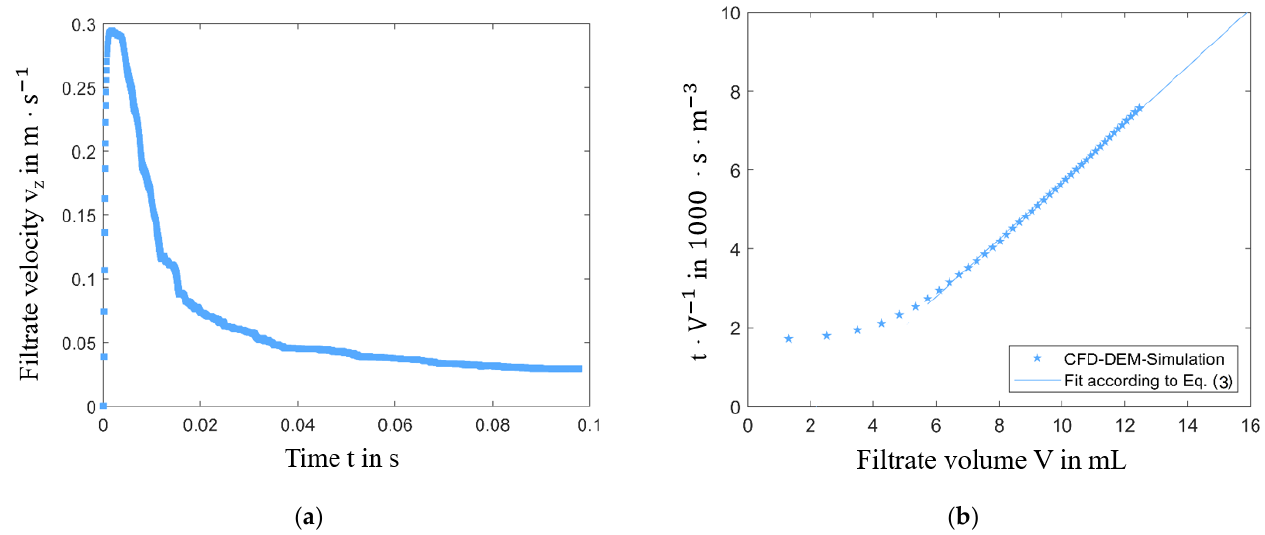
Figure 19. ( a ) Time-dependent filtrate velocity and ( b ) filter curve obtained with CFD-DEM simulation and described by filter equation in Equation (3).